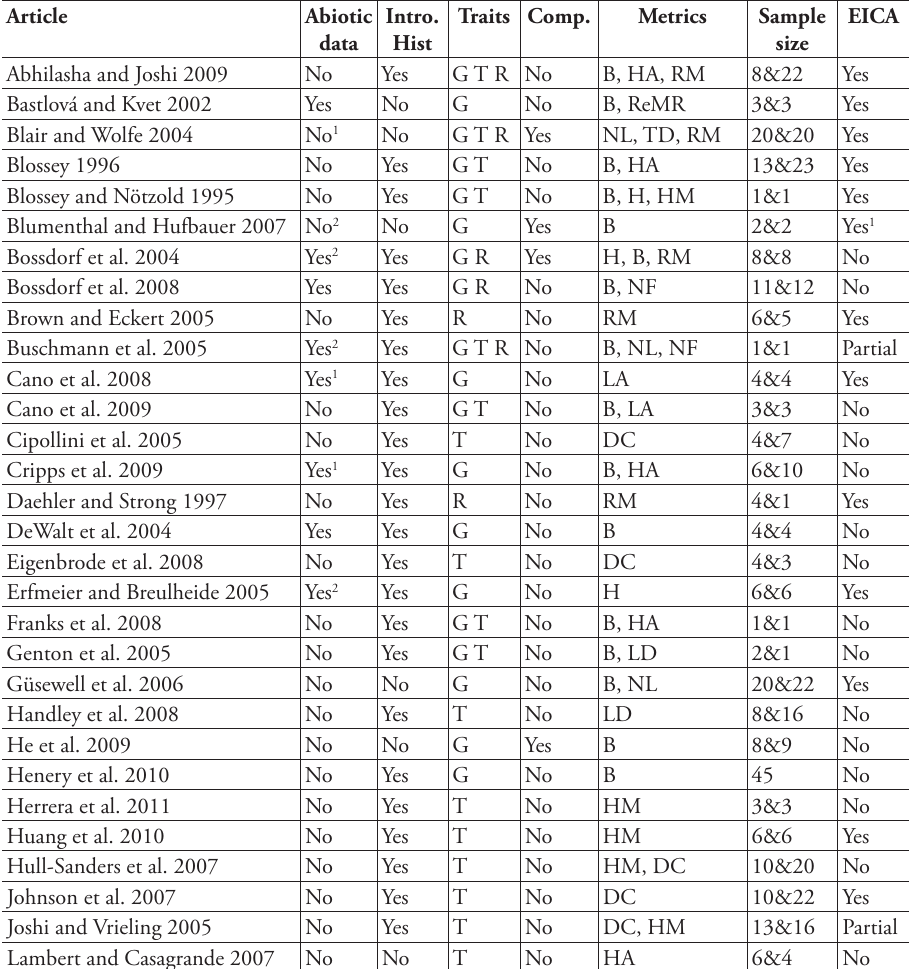
table 2. Design parameters of studies testing the EICA hypothesis. In the column labeled “Abiotic data,” “1” indicates that researchers tried to incorporate a variety of abiotic environments in seed collection sites while “2” indicates that researchers tried to utilize similar environments. In the column “Traits,” “G” = vegetative growth, “T” = herbivore tolerance, and “R” = reproductive effort. The column labeled “Comp.” indicates whether or not competition was incorporated into experimental manipulations. For “Metrics,” growth metrics are denoted by “B” = biomass, “H” = height, “NL” = number of leaves, “ “LA” = leaf area, “BA” = basal area; tolerance metrics are denoted by “HM” = herbivore mass, “HA” = herbivore abun- dance, “LD” = leaf damage, “DC” = defense chemicals, “TD” = trichome density; reproductive metrics are denoted by “RM” = reproductive mass, “ReMR” = reproductive mass ratio, and “NF” = number of fruits. In the column “Sample Size,” the values correspond to the number of native and nonnative populations used, respectively, unless the sample size was not differentiated by range. The column “EICA” indicates whether support was found, with “Partial” indicating that multiple traits were tested but not all results supported predictions, and “1” indicating that support was found, but only when plants were grown in the absence of competition. Abiotic Intro. Traits Comp. data Hist